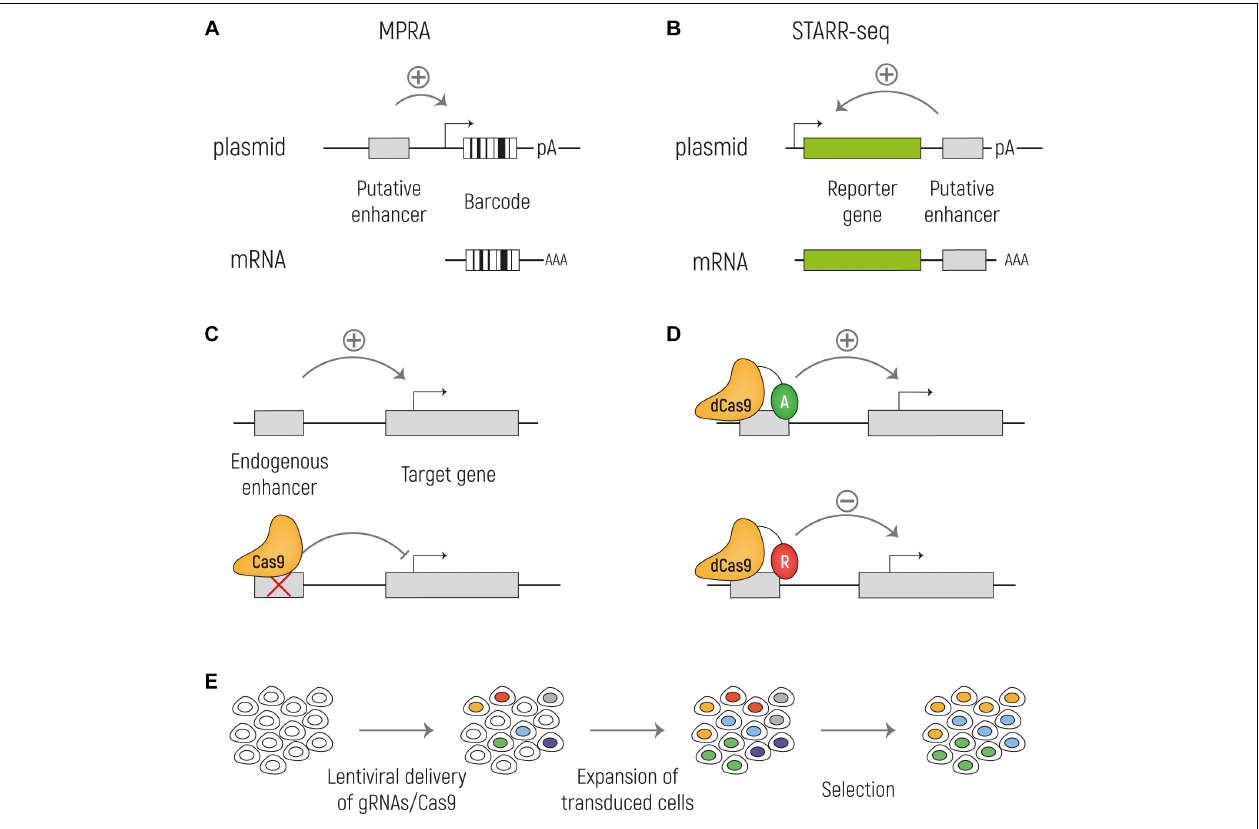
FIGURE 3 | Methods for functional identification of enhancers. (A) Massively parallel reporter assays (MPRA) to test enhancer activity in an episomal setup. The putative enhancer sequence is cloned upstream a minimal promoter that drives the expression of a reporter gene and a unique barcode. (B) With STARR-seq the putative enhancer sequence is cloned downstream the reporter gene and upstream of the polyA signal. When the enhancer sequence is active, it can drive the expression of the reporter (green) and of itself. In both MPRA and STARR-seq the mRNA is sequenced to identify the active enhancers. (C) Cas9 can be used to knock out an enhancer at the endogenous genomic locus to assess its effect on the target gene transcription. (D) A catalytically inactive Cas9 (dCas9) can be fused with activators (A: VP64; TET1; p300) or repressors (R: KRAB; SID4X; DNMT3A; KDM1A). (E) Cas9 screens can be combined with high-throughput screenings by targeting Cas9 expressing cells with a lentiviral library of gRNA at a low MOI. By doing so, each cell will express a single gRNA and by different selections, such as drug resistance or reporter gene expression, it is possible to investigate the effect of the ablation of a large number of putative enhancers on gene expression in